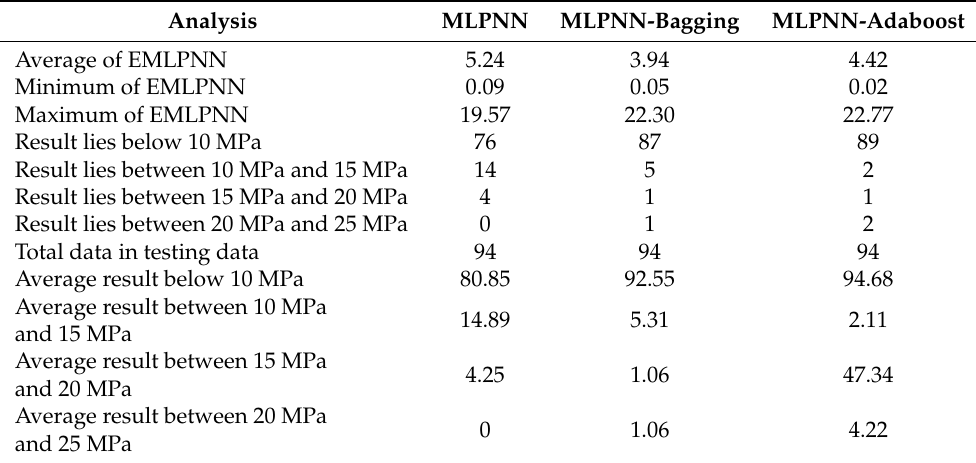
Figure 10. ( a ) Forecasted vs target for MLPNN; ( b ) MLPNN error distribution; ( c ) forecasted vs actual for MLPNN-bagging; ( d ) MLPNN-bagging error distribution; ( e ) forecasted vs target MLPNN- boosting; ( f ) error distribution of MLPNN-boosting. Table 7. Statistical results of the individual with ensemble MLPNN